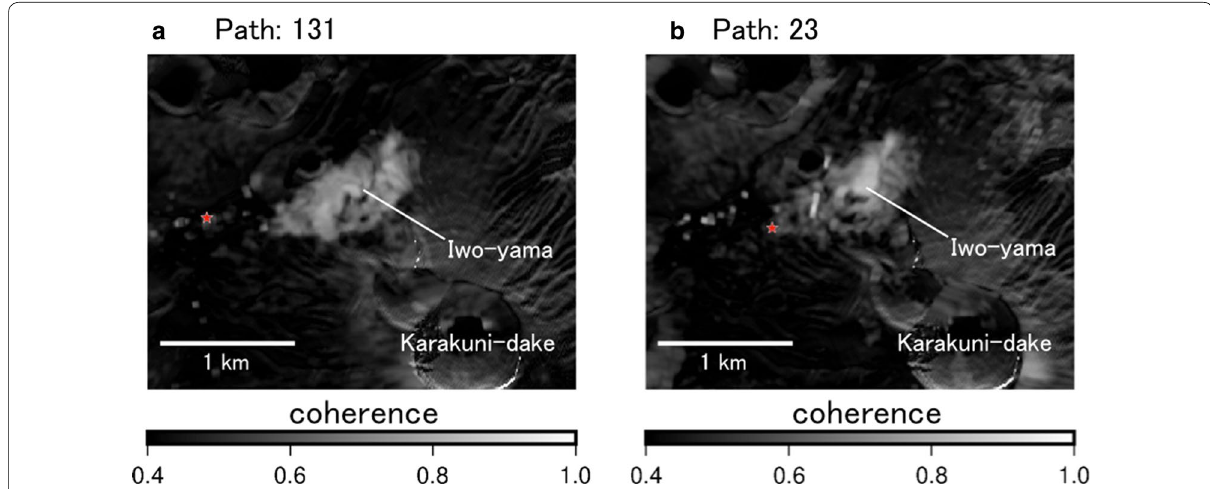
Fig. 3 Distributions of temporal mean values of coherence (stack coherence) in path a 131 and b 23. The area with stack coherence values of less than 0.4 is masked by black color. The red stars indicate reference pixels in each path. The reference pixels have stack coherence values of 0.56 in path 131 and 0.51 in path